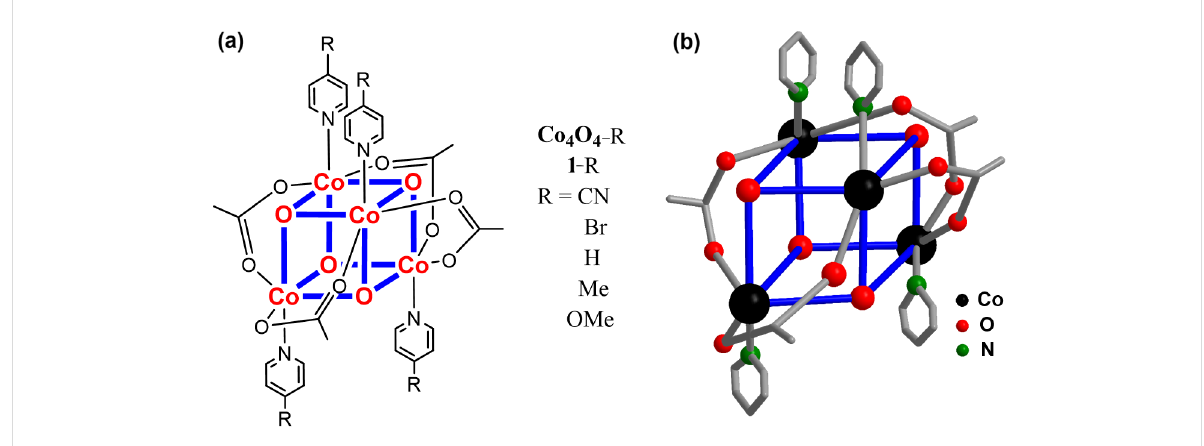
Figure 1: (a) Molecular structures of the Co 4 O 4 cubane catalysts. (b) Ball-and-stick representation of complex 1 -H; H atoms are omitted for